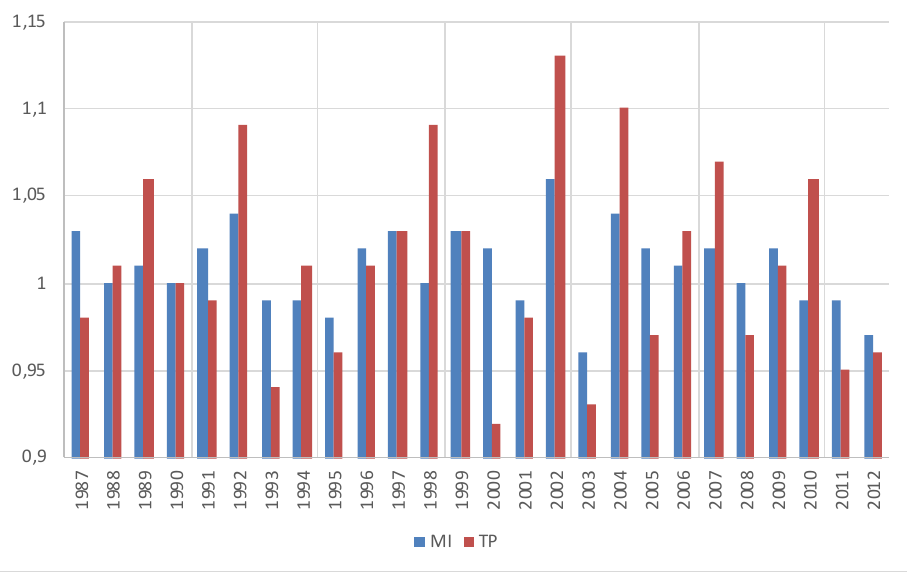
Figure 3. The Malmquist index (MI) and technical progress (TP) in EU-12,